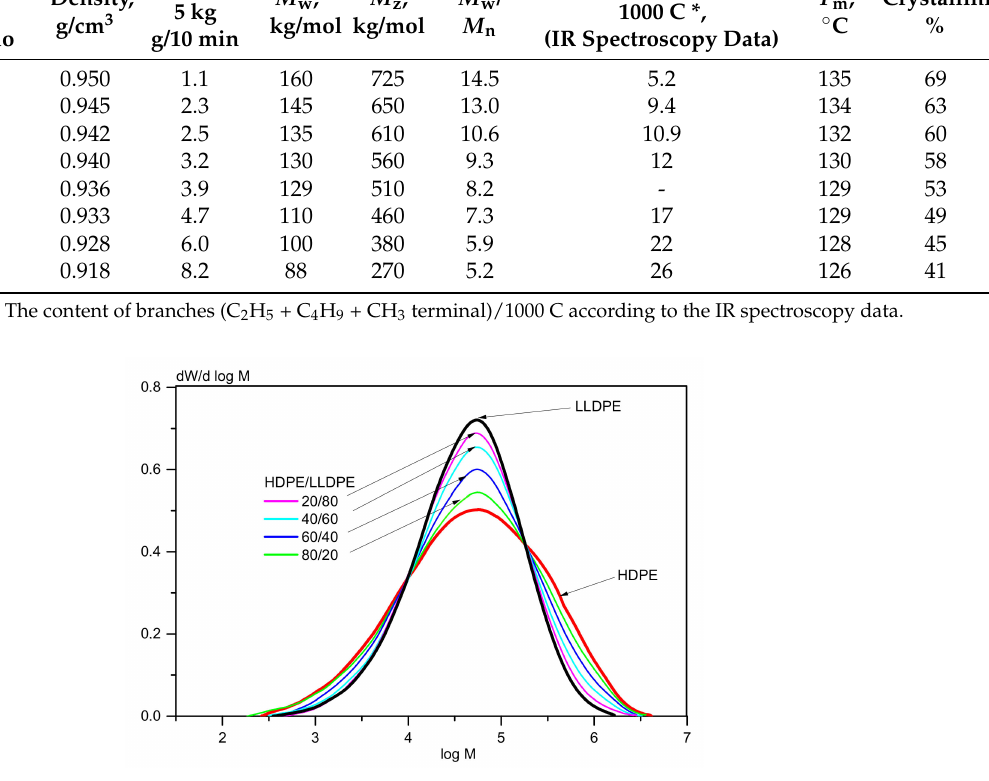
Figure 9. The MWD curves of the samples of bimodal HDPE and ter-co-LLDPE and their blends. The shape of the MWD curves for binary blends depends on the HDPE/LLDPE ratio in them. The peak on the MWD curve of the bimodal HDPE referring to the high-molecular- weight fraction becomes lower and is almost not detected as the LLDPE content is increased to ≥ 40%. The density and crystallinity of the blends also decreases proportionally with rising LLDPE